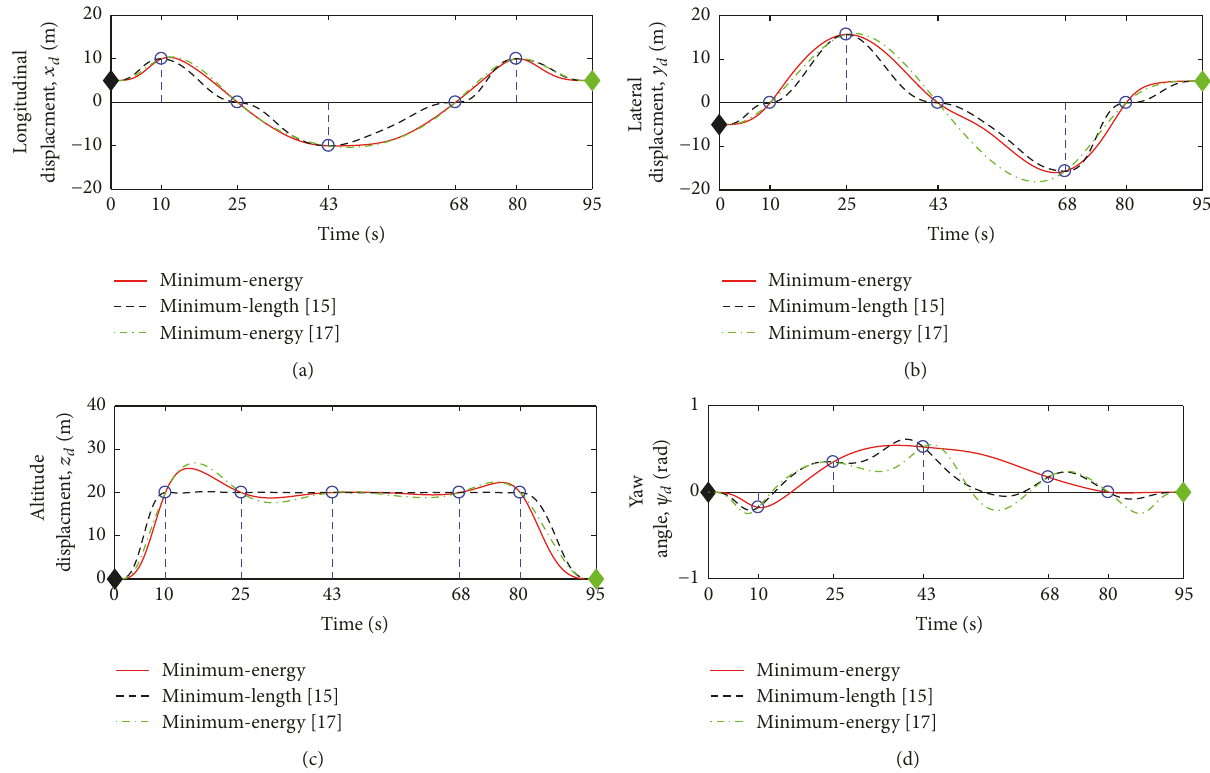
Figure 4: Desired (a) longitudinal, (b) lateral, and (c) altitude displacements and (d) heading angle, respectively.